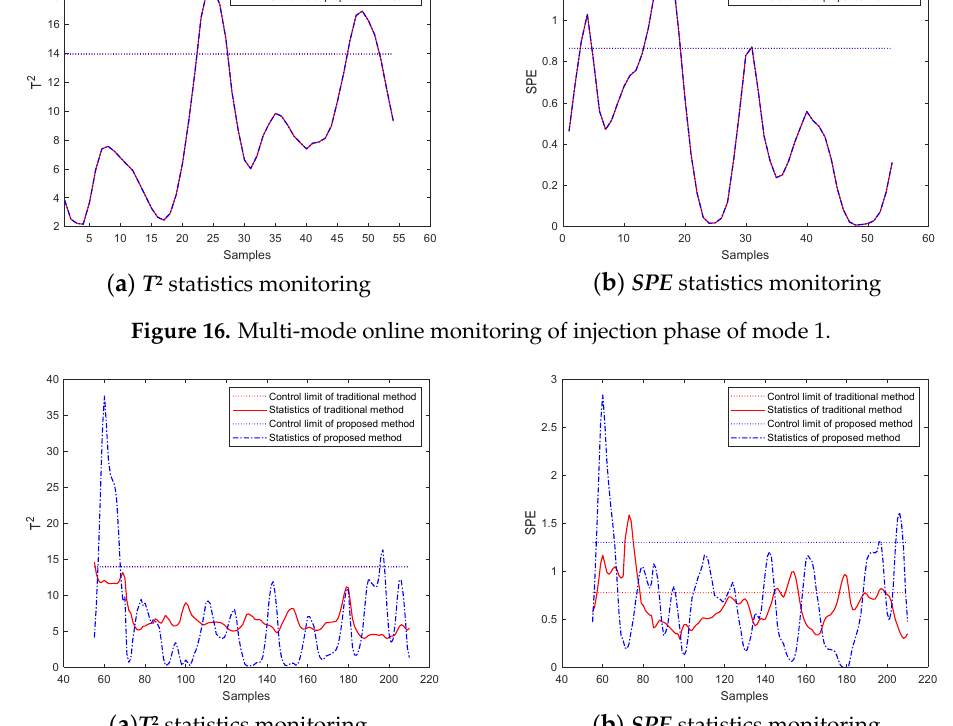
Figure 17. Multi-mode online monitoring of packing-holding phase of mode 1.